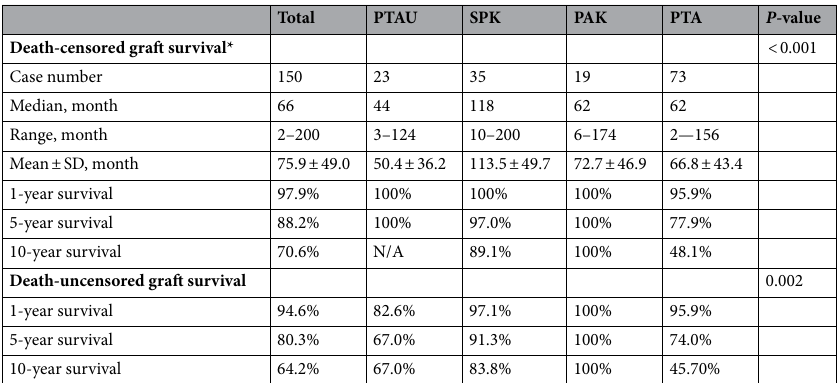
Table 4. Survival of pancreas grafts after pancreas transplant. PTAU pancreas transplant alone in uremic patients, SPK simultaneous pancreas and kidney transplant, PTA pancreas transplant alone, PAK pancreas after kidney transplant, N/A not available, *technique failure was not included, and graft loss due to patient death with functioning graft was considered as censor.